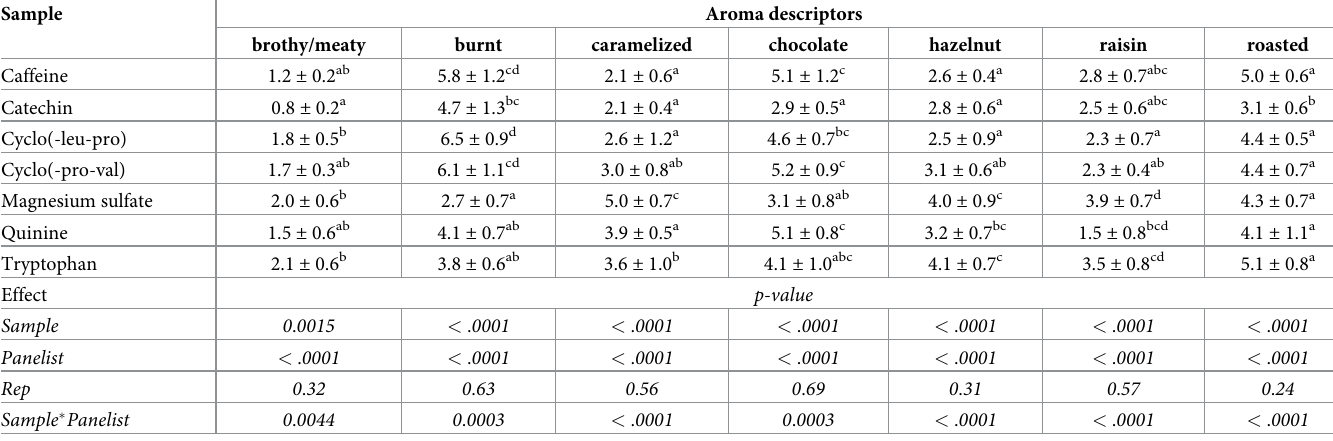
Table 2. Analysis of variance results from sensory descriptive analysis of retronasal coffee aroma and mean intensities ( ± Standard Error) (n = 8).